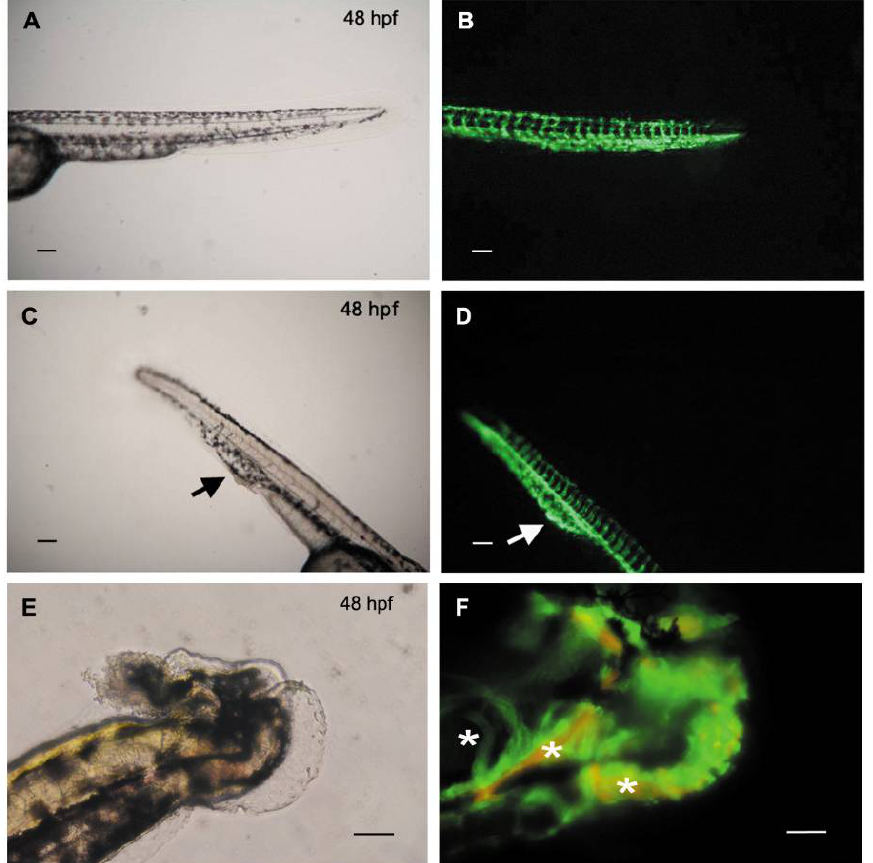
Figure 4. Knockdown of hyaluronan synthases 2 gene ( HAS2 ) in zebrafish embryos leads to defective venous structure with blood flow stasis. Tg ( fli1 : egfp ) xTg ( gata1 : dsRed ) zebrafish with green fluorescence emitting vasculature and red fluorescence emitting red blood cells are used to observe the anatomic change of vasculature (green fluorescence) and blood flow (red fluorescence). ( A ) Morphology of the tail of a representative wild-type zebrafish (48 hpf) under bright field microscope; ( B ) Vascular structure of the same zebrafish tail under fluorescence microscope; ( C ) Morphology of the tail of a representative HAS2 -morpholino (MO) injected zebrafish (48 hpf) under bright field microscope. A protruding bulb in the tail is noted (black arrow), mimicking human phenotype of varicose vein; ( D ) Vascular structure of the same HAS2-MO injected zebrafish tail under fluorescence microscope. A corresponding local dilation of venous structure in the caudal vein plexus (CVP) is found (white arrow); ( E ) Morphology of a representative HAS2 -morpholino (MO) injected zebrafish (48 hpf) with tail malformation under bright field microscope; ( F ) Vascular structure of the same HAS2-MO injected zebrafish tail under fluorescence microscope. Tangled veins are found in the mal-formatted tail (white stars). Magnification is 100 × in ( A – D ) and 200 × in ( E , F ). Scale bar = 100 µ m. Hpf indicates hours post-fertilization.